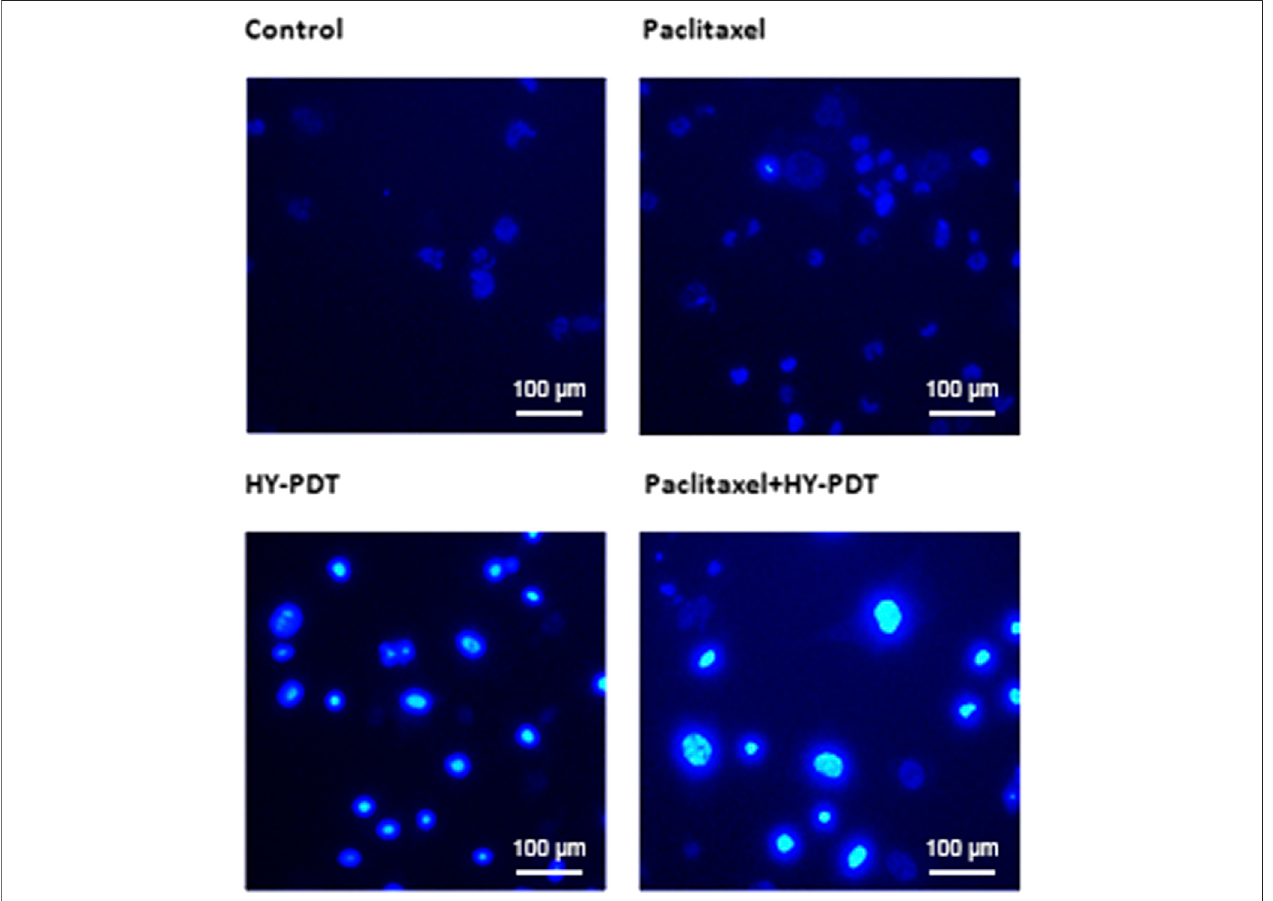
FIGURE 2 | Morphology detection of B16-F10 nucleus after treatment with paclitaxel or HY-PDT or the combination. Fluorescence graph of Hoechst 33,342 staining after B16-F10 cells were treated with paclitaxel (1 μ g/ml) and HY-PDT (1 μ g/ml) alone or in combination (0.5 μ g/ml each). Scale bars: 100 μ m.